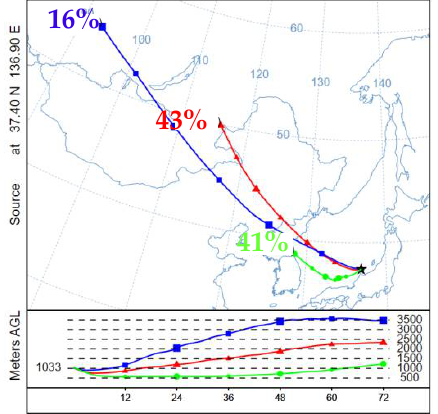
Figure 5. Cluster mean backward trajectory analysis during AD events from 2010 to 2015, and the different colours represent different transport pathways.